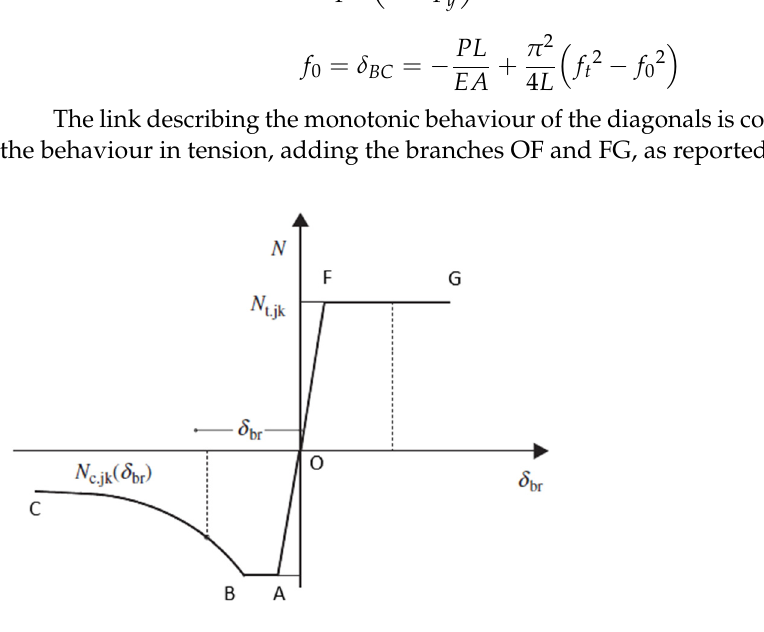
Figure 2. Monotonic behaviour for diagonal members in compression and